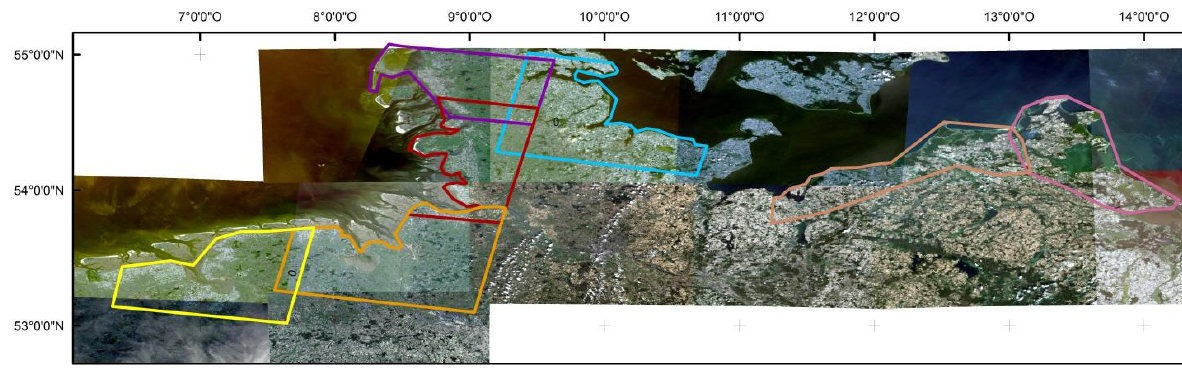
Figure 1: Overview of the area of investigation and the already processed patches (colours related to table 1) from PSI. Background satellite image based on Sentinel-2 data.